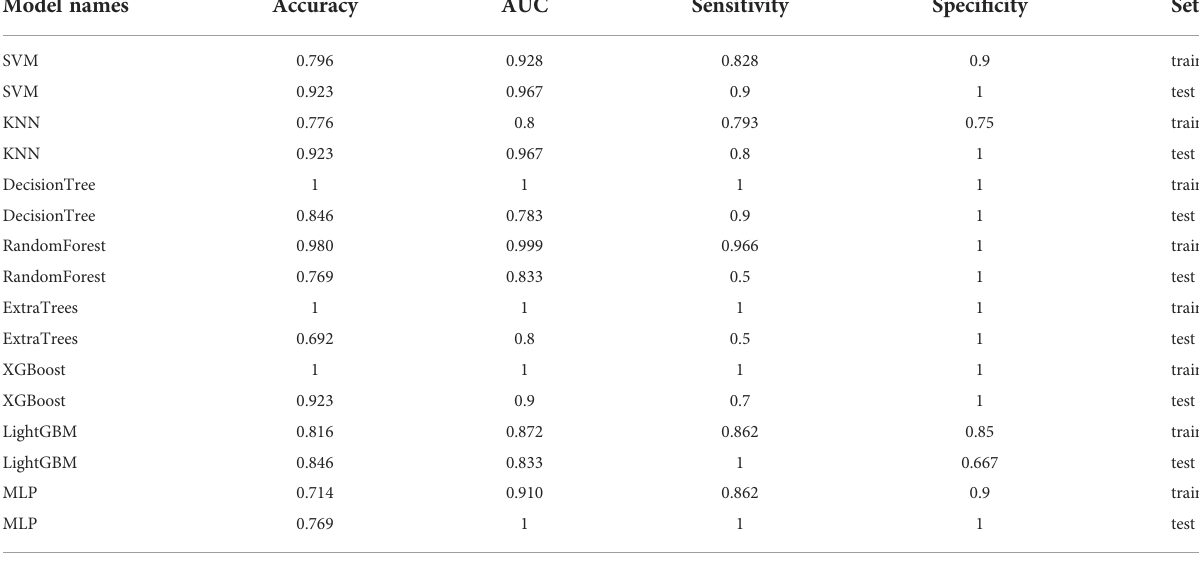
TABLE 10 Each evaluation index of the best performance of 100 random groupings in eight machine learning algorithms.